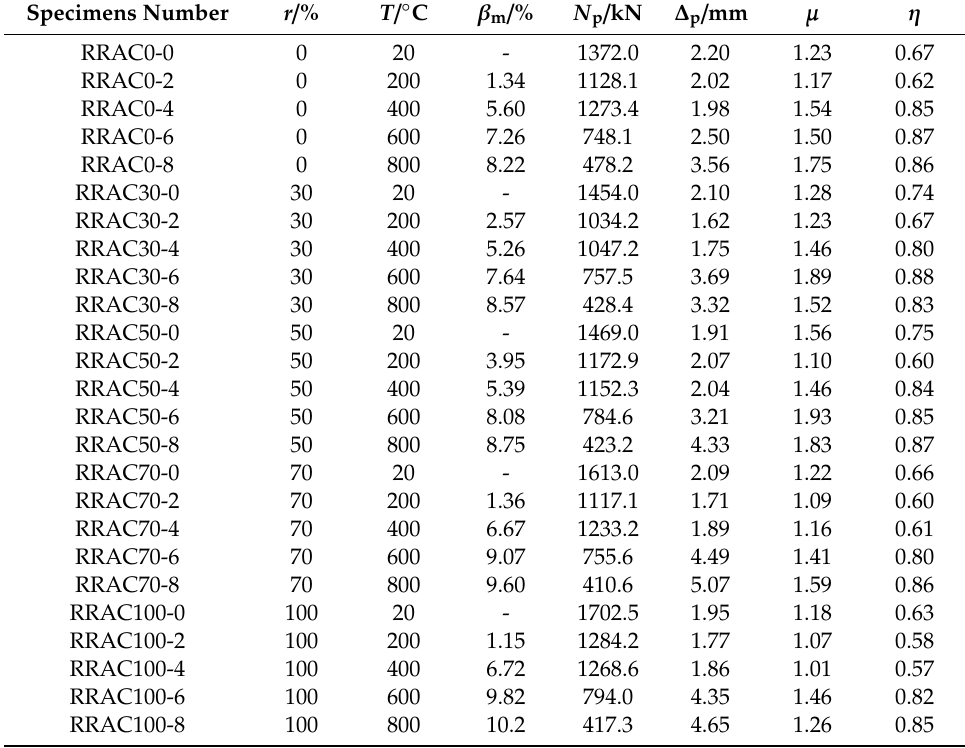
Table 4. Design parameters and experimental results of reinforced recycled aggregate concrete (RRAC)